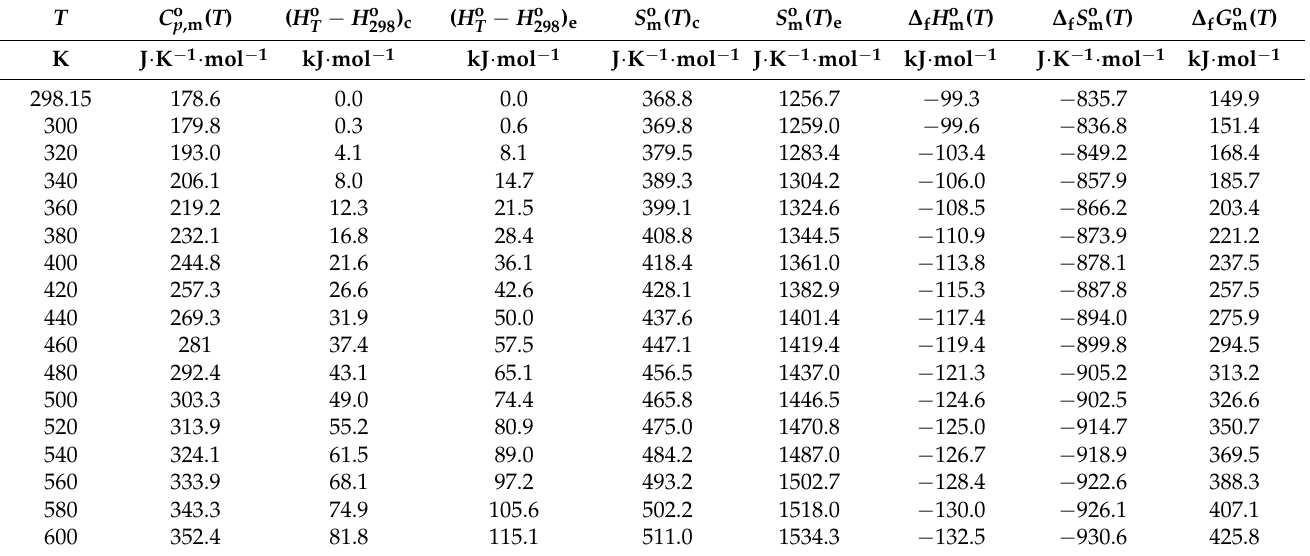
Table 12. Gas-phase standard molar thermodynamic properties of 2-methyl-H8-indole at p = 0.1